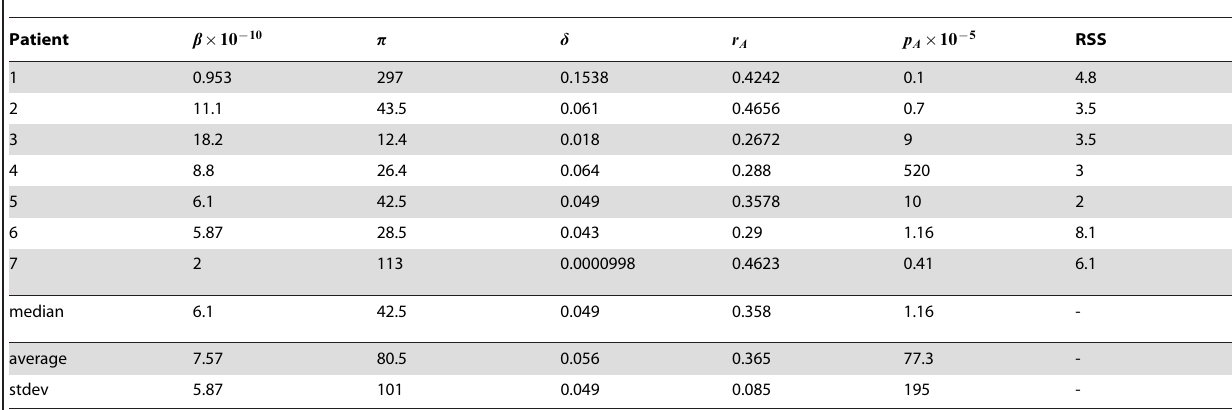
Table 2. Parameter best